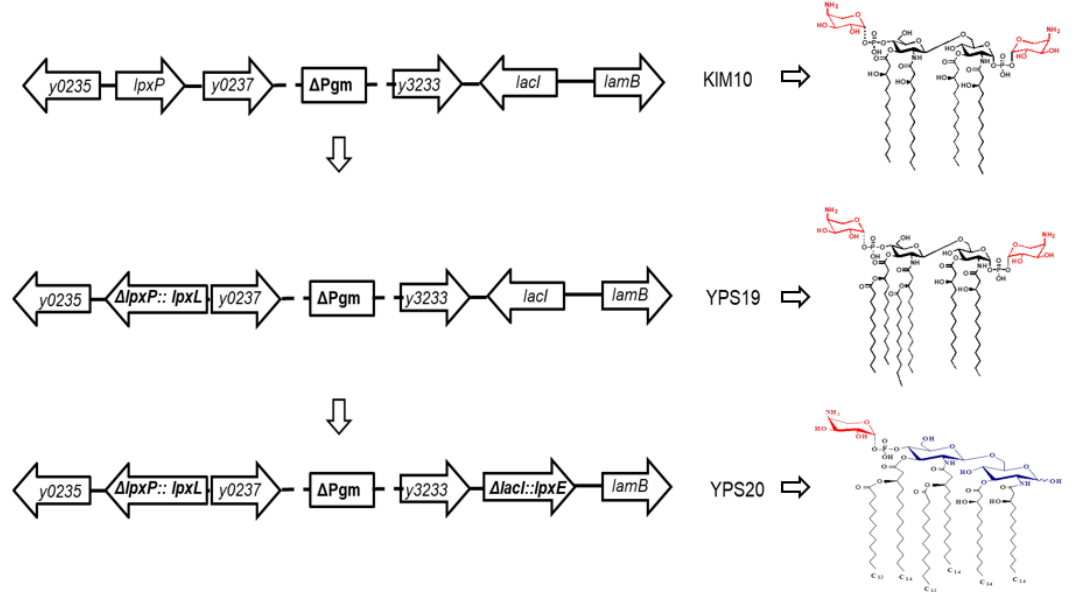
Figure 1. Schematic chromosome structure of Y. pestis KIM10 (Pgm − pPCP1 − , pCD1 − ), YPS19 ( Δ lpxP32 ::P lpxL lpxL , Pgm − pPCP1 − , pCD1 − ), and YPS20 ( Δ lpxP32 ::P lpxL lpxL ∆lacI23 ::P lpp lpxE , Pgm −